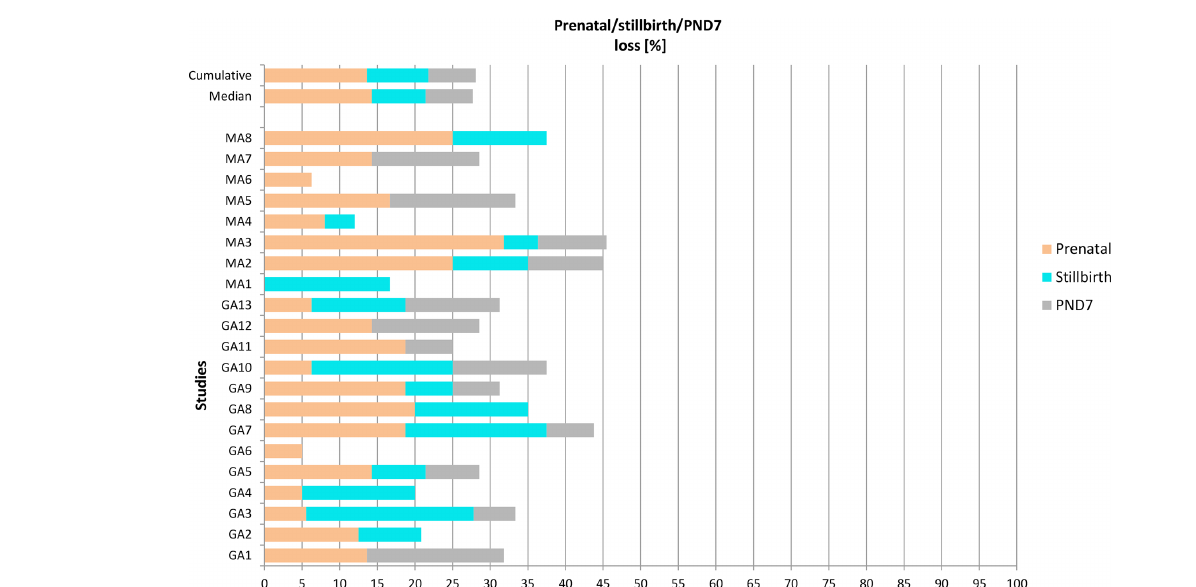
Figure 1. Prenatal loss, stillbirth, and postnatal loss until postnatal day 7 (PND7) in 21 ePPND Studies for Münster (GA1-13) and Madison (MA1-8). Group sizes at study start were 14–24 animals per